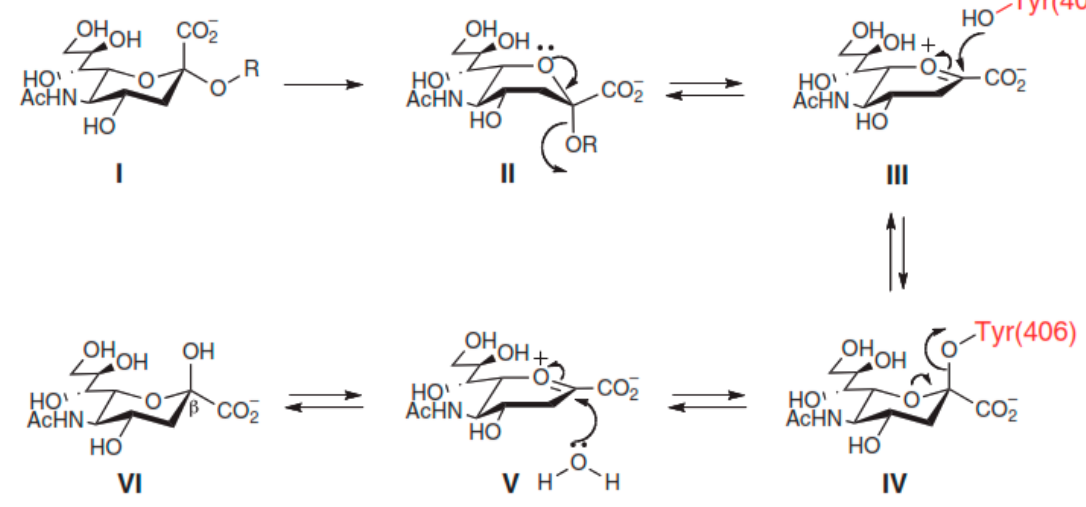
Figure 8. Catalytic Mechanism of NA showing four major steps of NA Inhibitors [190].